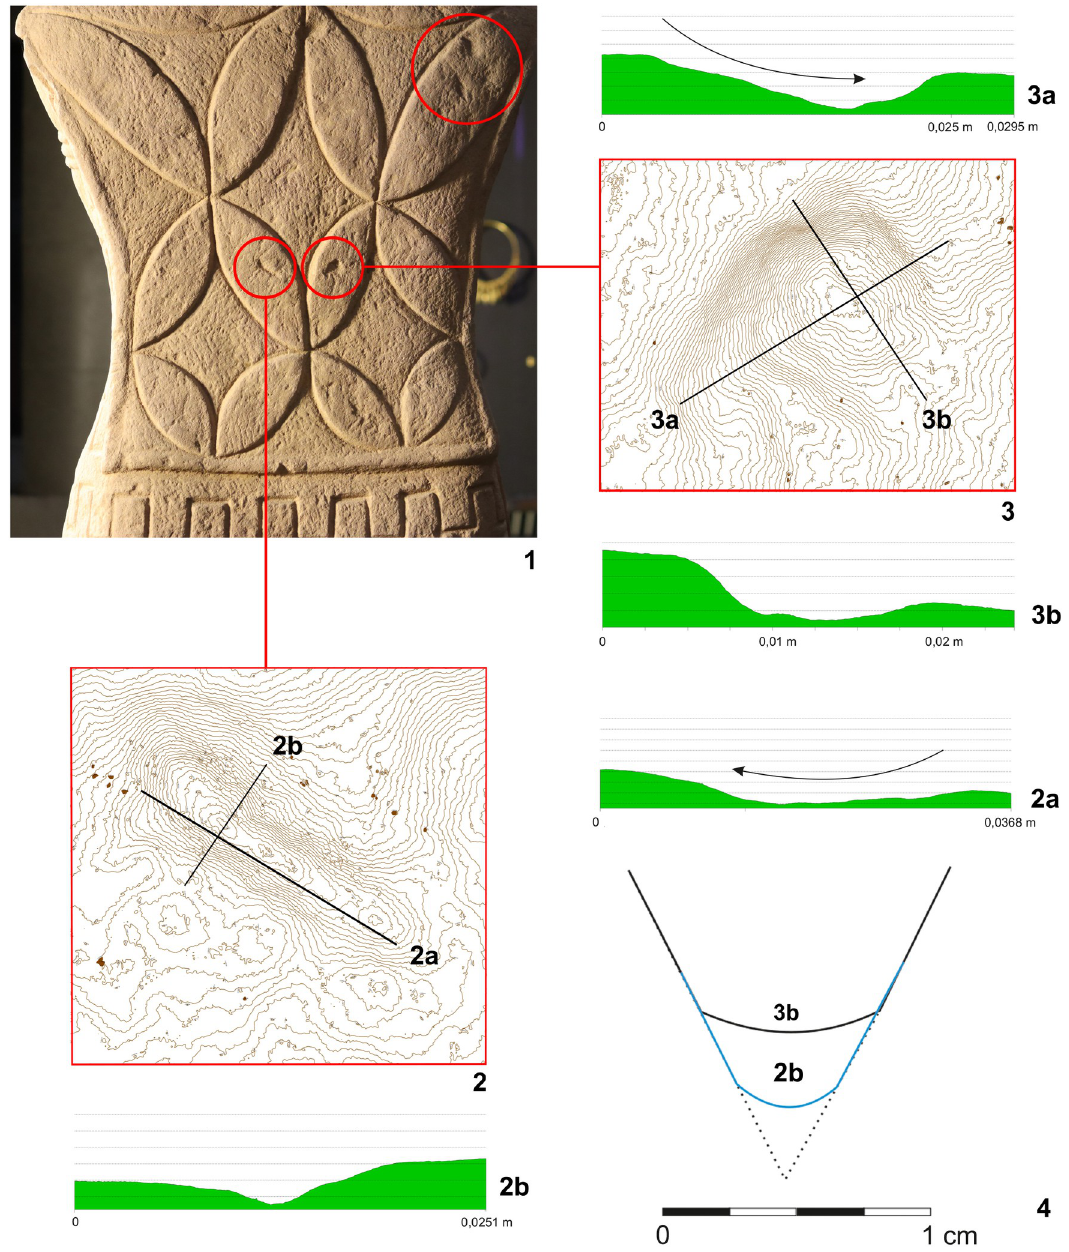
Fig 16. Statue 1 from Glauberg. 1 the sculpture´s back with the traces of the pick (in red circles); 2 isoline model of one of the traces; 2a longitudinal section of the trace; 2b transverse section of the trace; 3 isoline model of one of the traces; 3a longitudinal section of the trace; 3b transverse section of the trace; 4 reconstructed point of the pick as derived from the sections of the traces (author: M. Cihla and F. R. Va´clavı´k). must have been levelled, probably using a chisel with a broader blade. Although the directly visible traces of this intermediate phase did not survive, occasionally we observed indications of broader cuts, subsequently being crossed at a right angle by traces of the forementioned slim chisel.